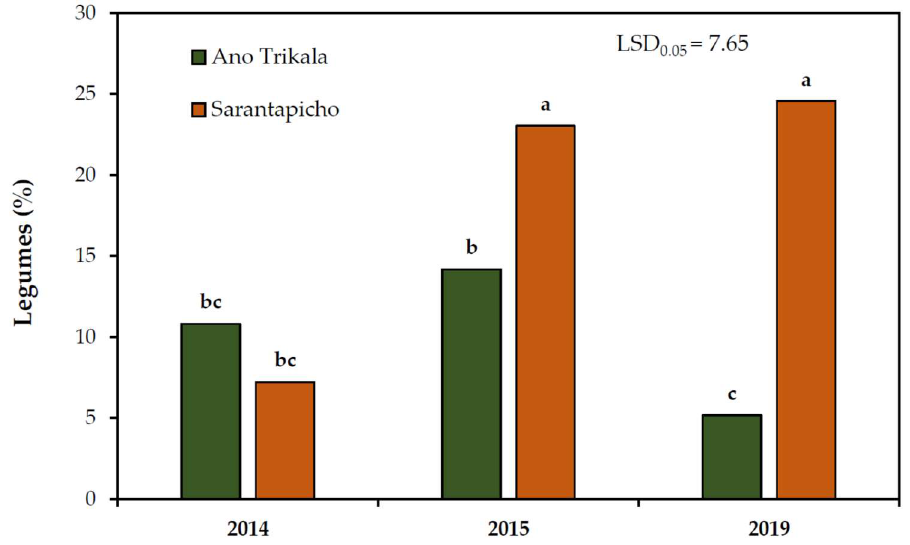
Figure 2. Effects of site and year on legumes percentage. Columns followed by the same letter are not significantly different ( p >